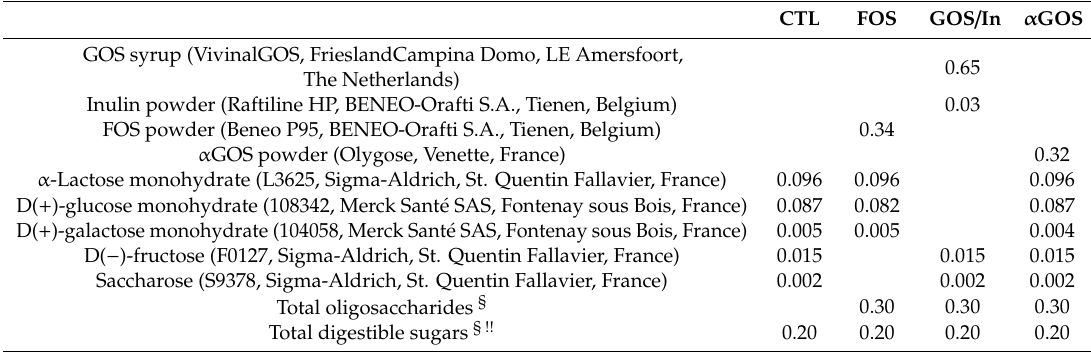
Saccharose (S9378, Sigma-Aldrich, St. Quentin Fallavier,